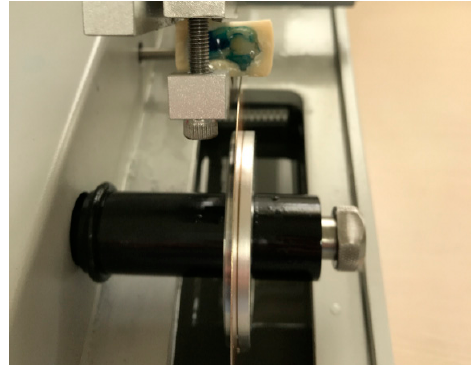
Figure 2. Tooth cut in half using a high precision Beuhler cutter. Rig is on the left, cut tooth sample on the right.